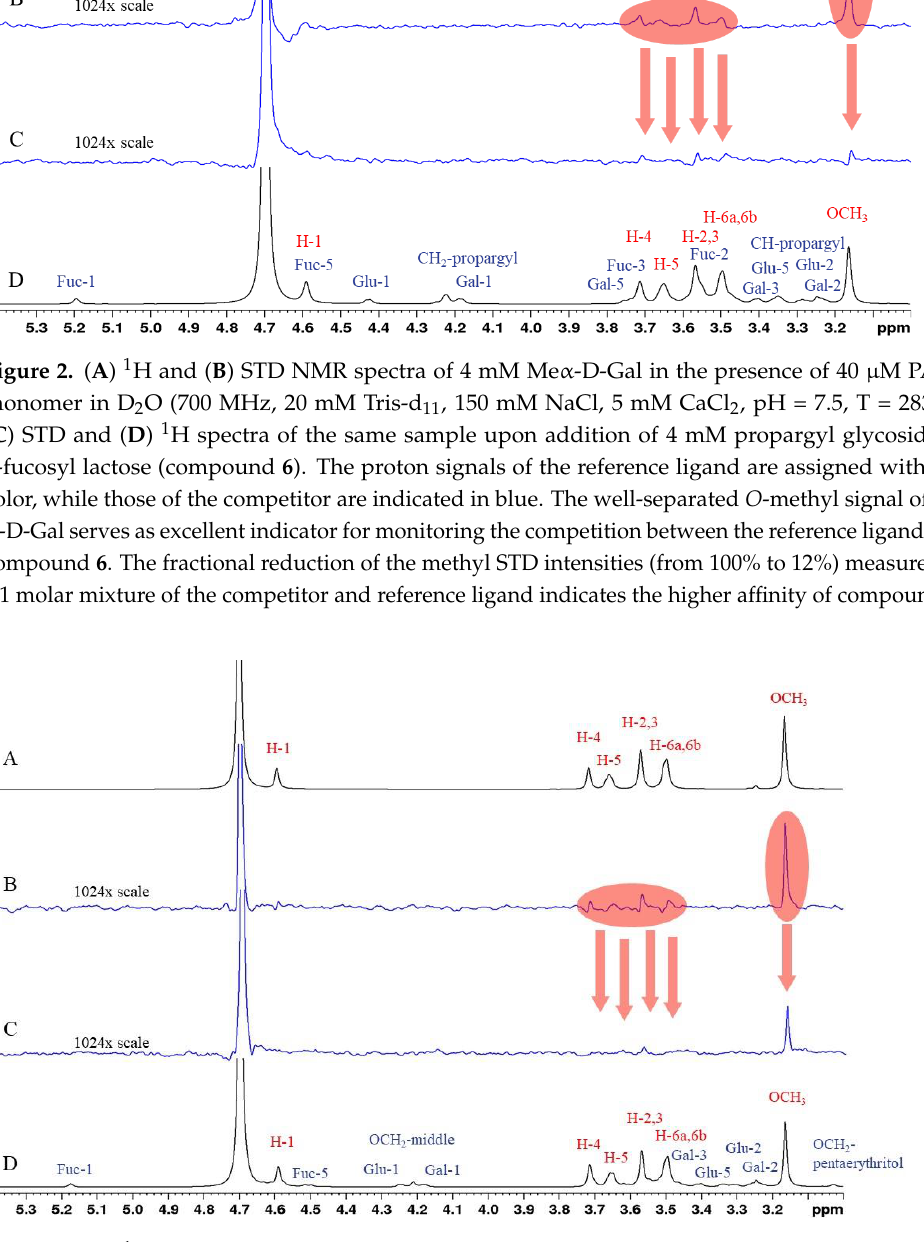
Figure 3. ( A ) 1 H and ( B ) STD NMR spectra of 4 mM Me α -D-Gal in the presence of 40 µ M PA-IL monomer in D 2 O (700 MHz, 20 mM Tris-d 11 , 150 mM NaCl, 5 mM CaCl 2 , pH = 7.5, T = 283 K). ( C ) STD and ( D ) 1 H spectra of the same sample titrated with 0.4 mM tetravalent 3-fucosyl lactose derivative (compound 8 ). The proton signals of the reference ligand are assigned with red color, while those of the competitor are indicated in blue. The fractional reduction of the methyl STD intensities (from 100% to 56%) measured in 1:10 molar mixture of the competitor and reference ligand confirms the binding and higher affinity of compound 8 .